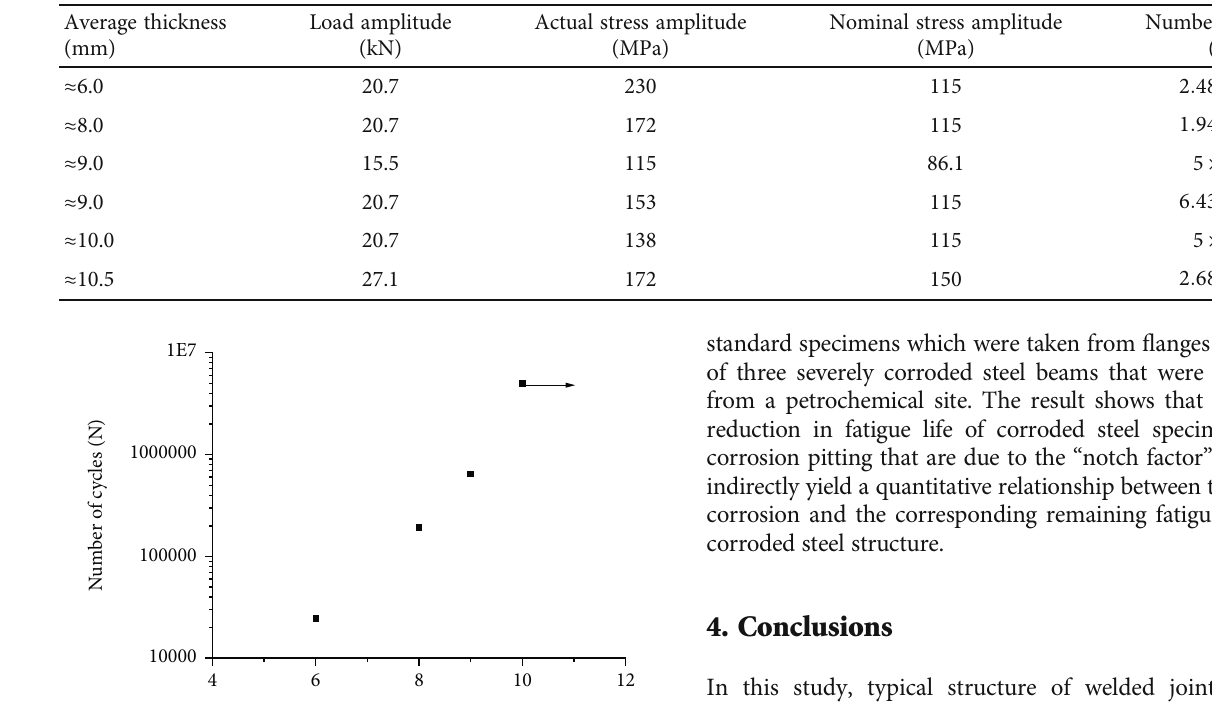
Table 3: Fatigue test results of bridge deck specimens.